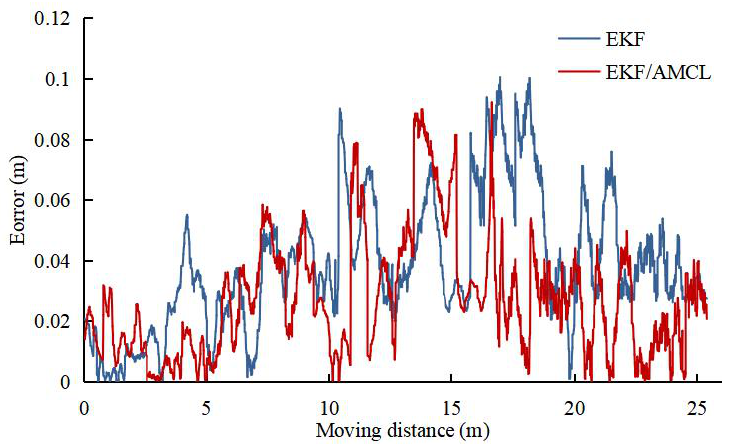
Figure 6. Comparison of lateral error between two integrated algorithms. Table 3. Analysis of lateral error of two integrated algorithms.